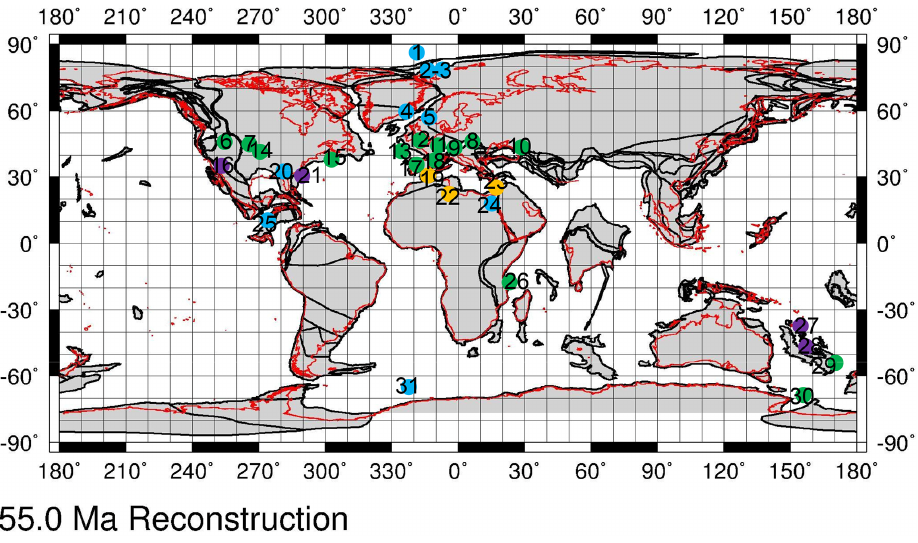
Figure 10. Paleogeographic map (from http://www.odsn.de/odsn/services/paleomap/paleomap.html) at 55Ma showing sites where paleohy- drological reconstructions for the PETM are available. Numbers follow a north to south paleolatitudinal order. Blue dots indicate areas where an increase in precipitation has been inferred; green dots indicate areas where an increase in climatic contrasts or a fluctuating precipitation regime has been inferred; orange dots indicate areas where an increase in aridity has been inferred; purple dots indicate areas where hydrolog- ical changes have been inferred but the pattern not specified. (1) Lomonosov Ridge, Arctic Sea; (2, 3) Spitsbergen central basin and Svalbard archipelago area; (4) central North Sea Basin; (5) eastern North Sea Basin; (6) Williston Basin, western North Dakota, (USA) (7) Bighorn Basin, Wyoming (USA); (8) Rhenodanubian Basin, Austria; (9) Belluno Basin, northeastern Italy; (10) Aktumsuk and Kaurtakapy sections, Uzbekistan and Kazakhstan; (11) Dieppe–Hampshire Basin, France; (12) London Basin; (13) DSDP Site 401 Bay of Biscay, northeastern Atlantic Ocean; (14) western Colorado (USA); (15) New Jersey Coastal Plain (USA); (16) Central Valley of California (USA); (17) Basque Basin, northern Spain; (18) Tremp Basin, northern Spain; (19) Alamedilla section, southern Spain; (20) Tornillo Basin, Texas (USA); (21) Salisbury embayment, mid-Atlantic coastal plain (USA); (22) Gafsa Basin, Tunisia; (23) Zin Valley of Negev, Israel; (24) Dababiya section, Egypt; (25) northern Neotropics (Colombia and Venezuela); (26) TDP Site 14, Tanzania; (27) Tawanui section, North Island (New Zealand); (28) Clarence River valley, South Island (New Zealand); (29) central Westland, South Island (New Zealand); (30) ODP Site 1172, East Tasman Plateau; (31) ODP Site 690 Weddell Sea, Southern Ocean. See Table S3 for references and additional